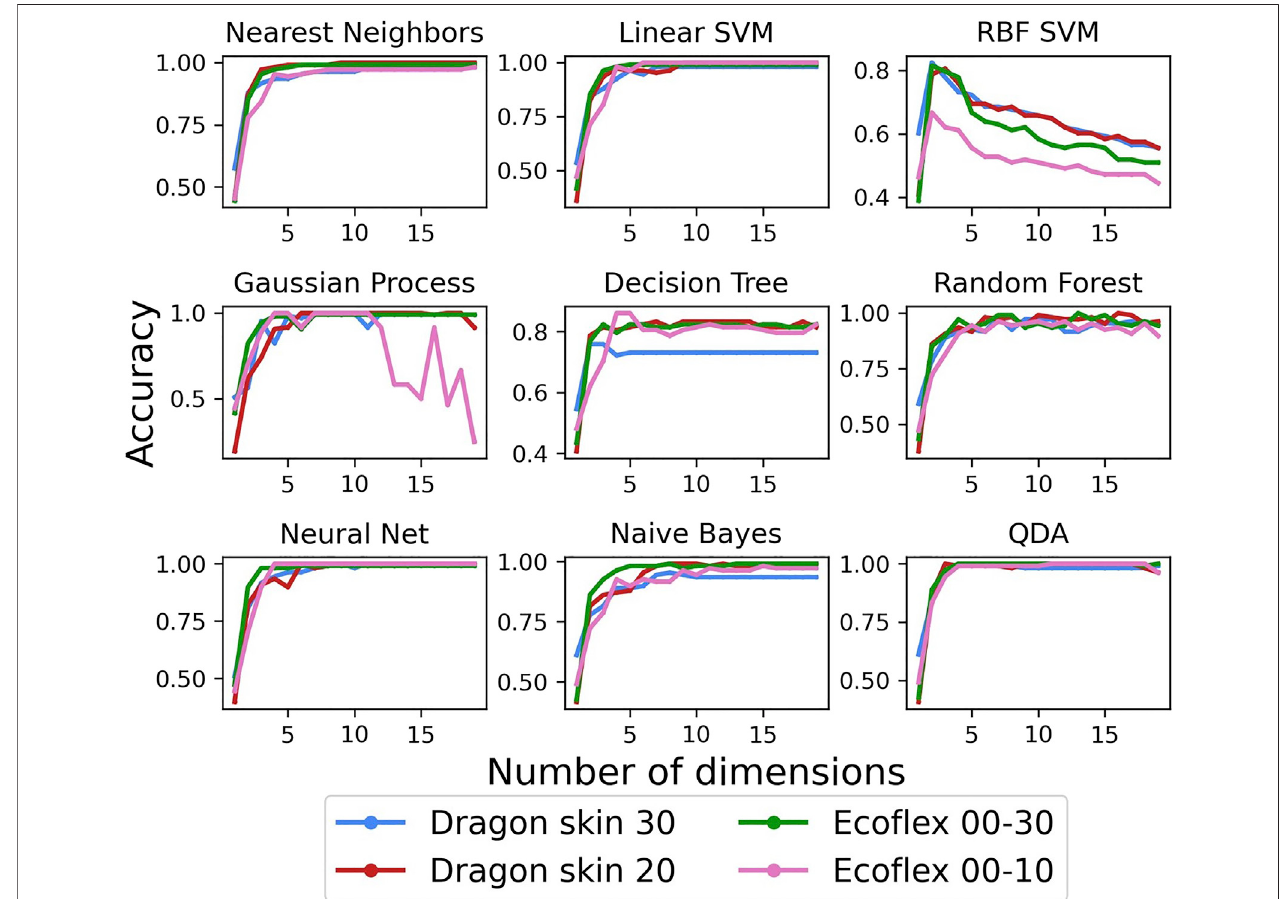
FIGURE 8 | Classi fi cation accuracy using the nine different classi fi ers as a function of the PCA dimensions.